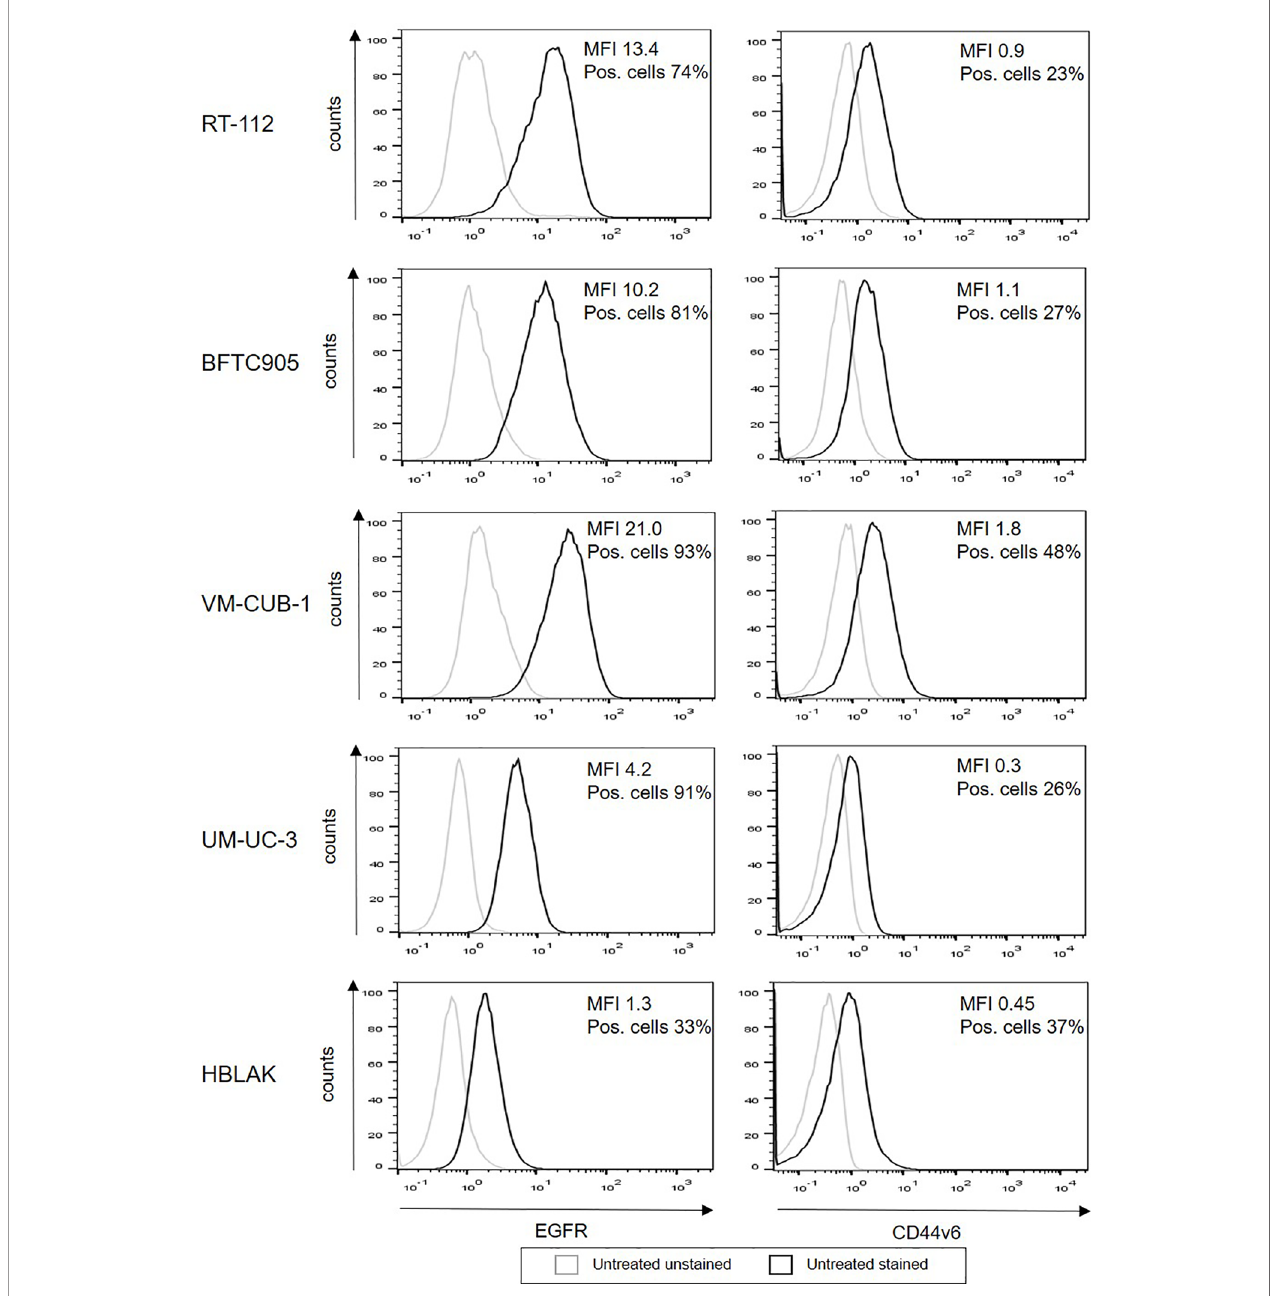
FIGURE 1 | Surface expression of EGFR and CD44v6 on untreated UCC and HBLAK. The UCC RT-112, BFTC905, VM-CUB-1, UM-UC-3, and benign HBLAK were stained with the indicated antibodies and analyzed by fl ow cytometry. The fi gure shows representative histograms out of at least three independent experiments for each cell line. Histogram of unstained cells appear in gray, stained cells in